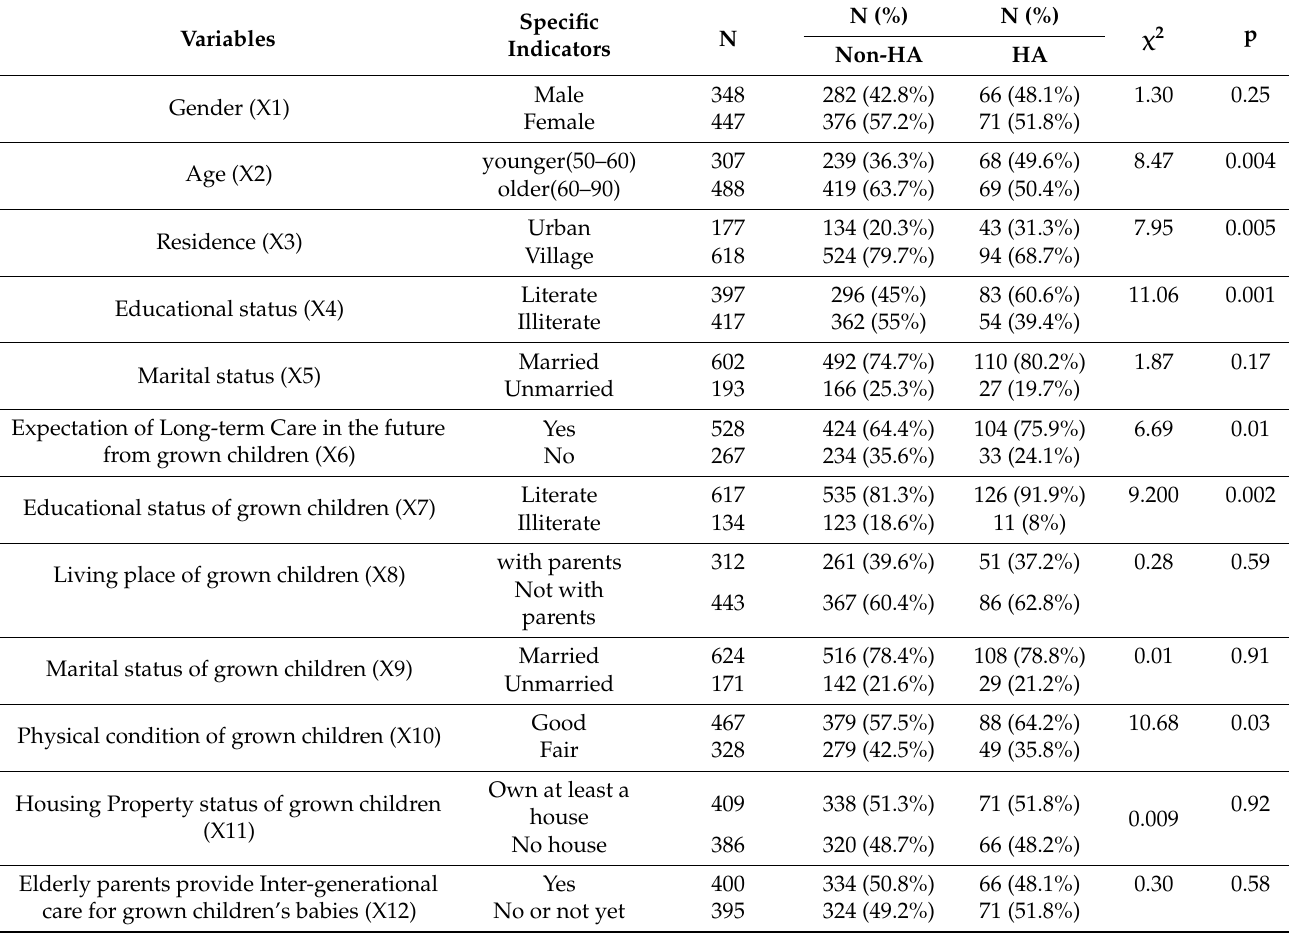
Table 2. Descriptive statistics of independent